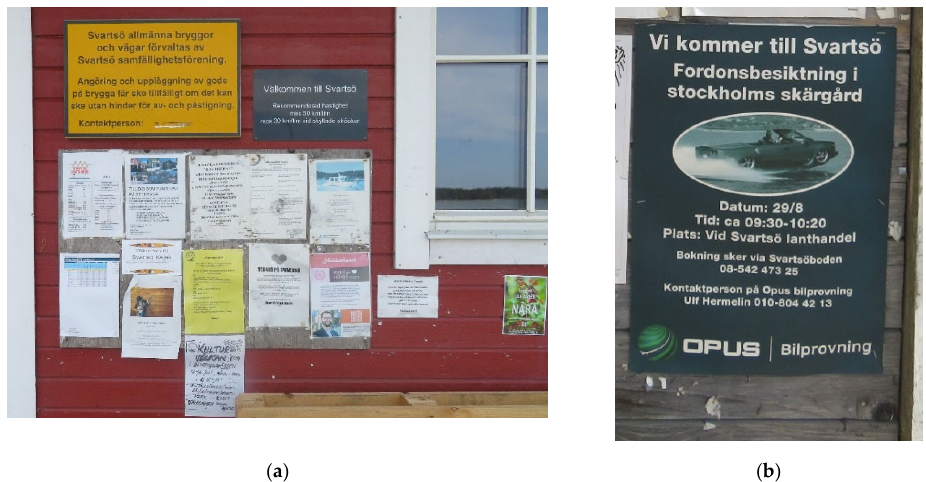
Figure 5. Examples from the linguistic landscape: ( a ) The bulletin bord by the jetty at Norra Svartsö; ( b ) a message about vehicle inspection service, “We’re coming to Svartsö” on the bulletin board at the central crossroads on Svartsö. Note the humorous image included in the sign in Figure 5b, evoking associations both with the service offered and the isolated position of the target audience, and thus highlighting the communicative potential of different semiotic resources found on signs beyond the verbal language.